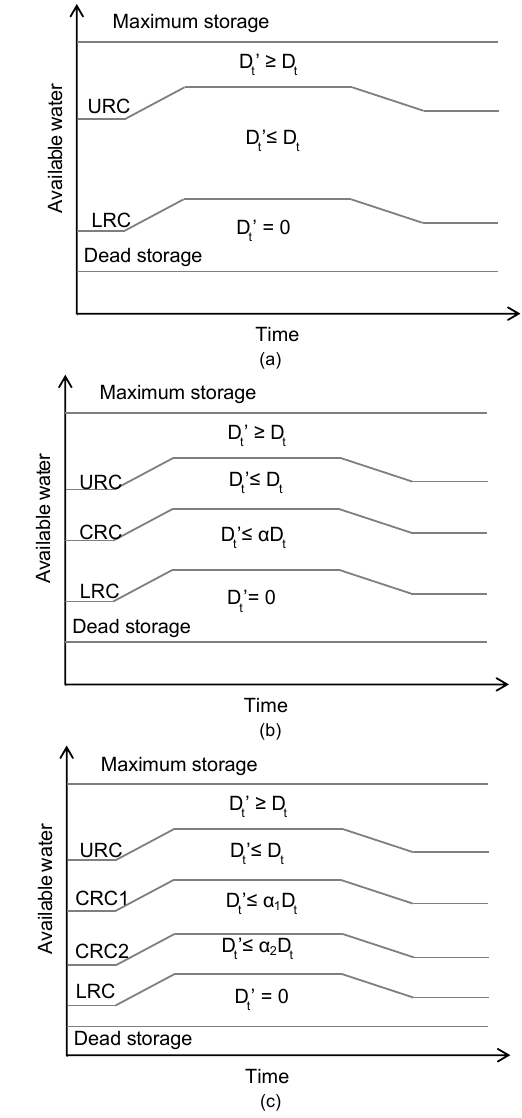
Figure 1. Schematic illustration of zone-based operating rules for (a) no-hedging; (b) single-stage hedging; and (c) two-stage hedg-